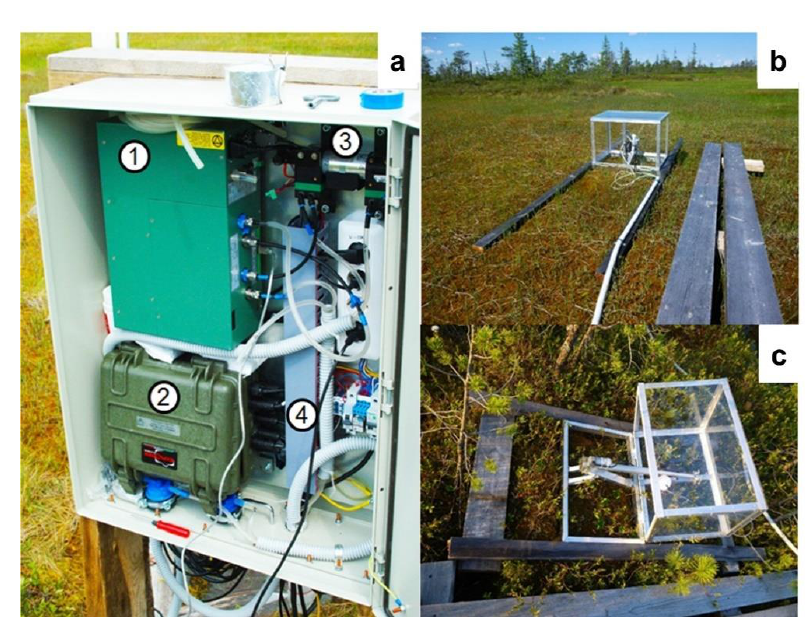
Figure A1. Overview of automated chamber system at the MFS. ( a ): Main unit; 1, gas analyser unit (Licor 7000); 2, controlling, logging and remote access unit; 3, pump; 4, power unit. ( b ): Chamber at the hollow site. ( c ): Chamber at the ridge site.